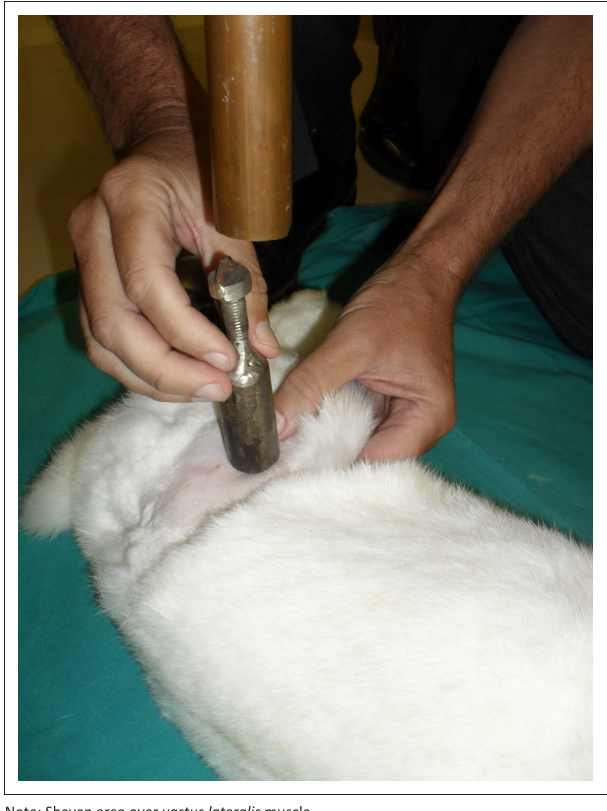
Note: Shaven area over vastus lateralis muscle. FIGURE 2: A 201 g elongated oval weight used to cause